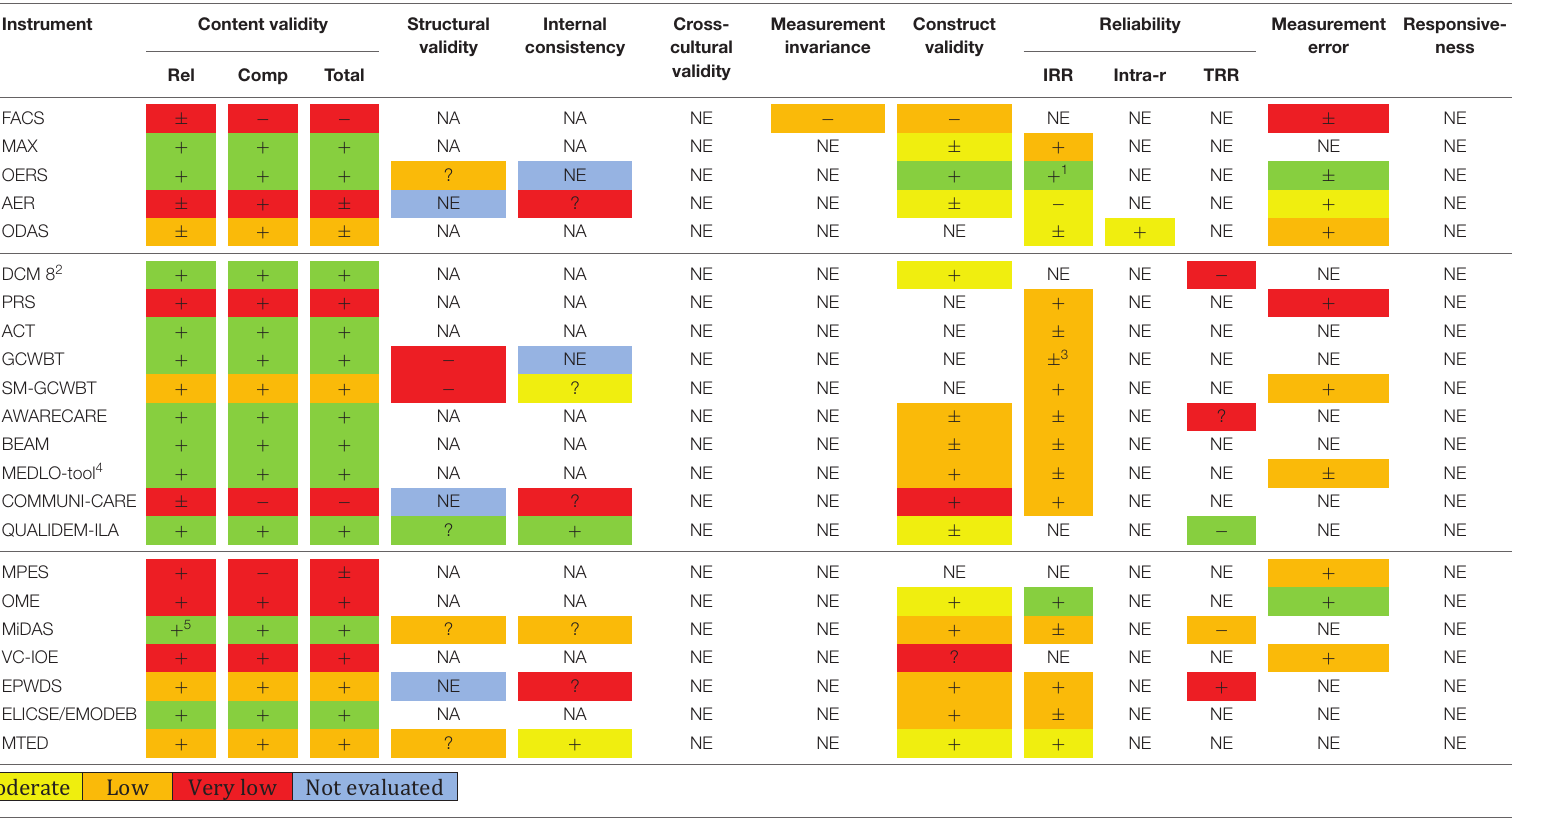
TABLE 4 | Rating against quality criteria and